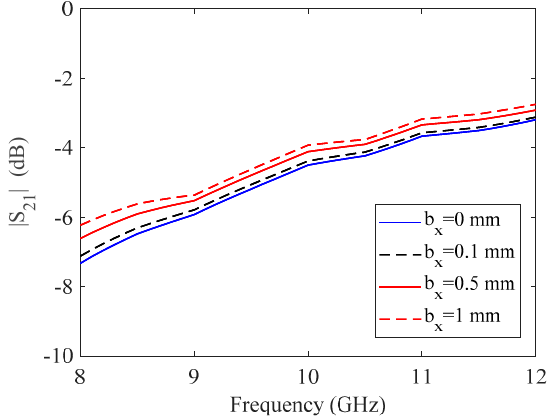
Figure 4. Analysis of fabrication tolerances of the plain cement composites.